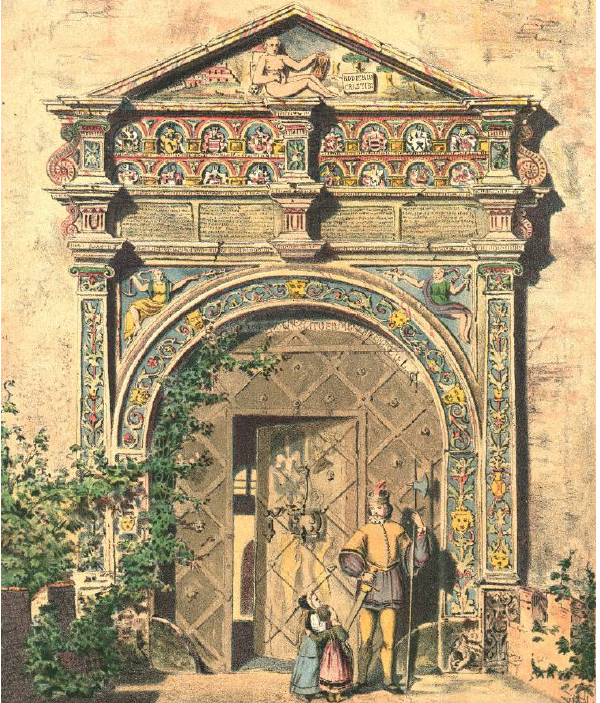
Figure 41. Reconstruction of the polychrome (on the basis of the preserved remains) of the portal of the manor house in Gola Dzierżoniowska. B. Mansfeld, lithograph undated. Source: Polska-org.pl (2017).